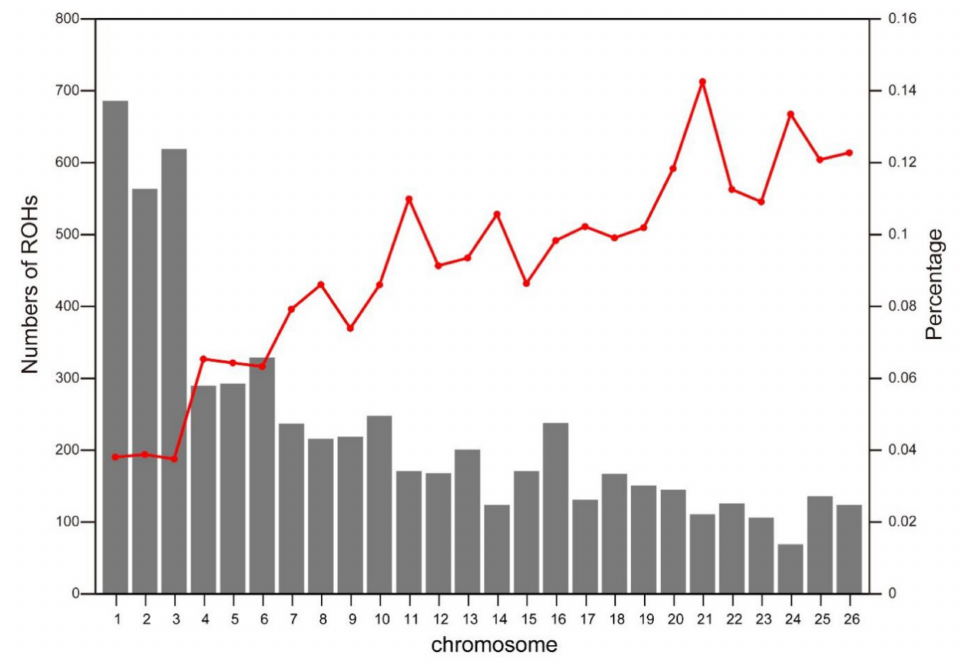
Figure3. TotalnumberofROHperchromosome(graybars)andaveragepercentageofeachchromosome covered by ROH (red line).